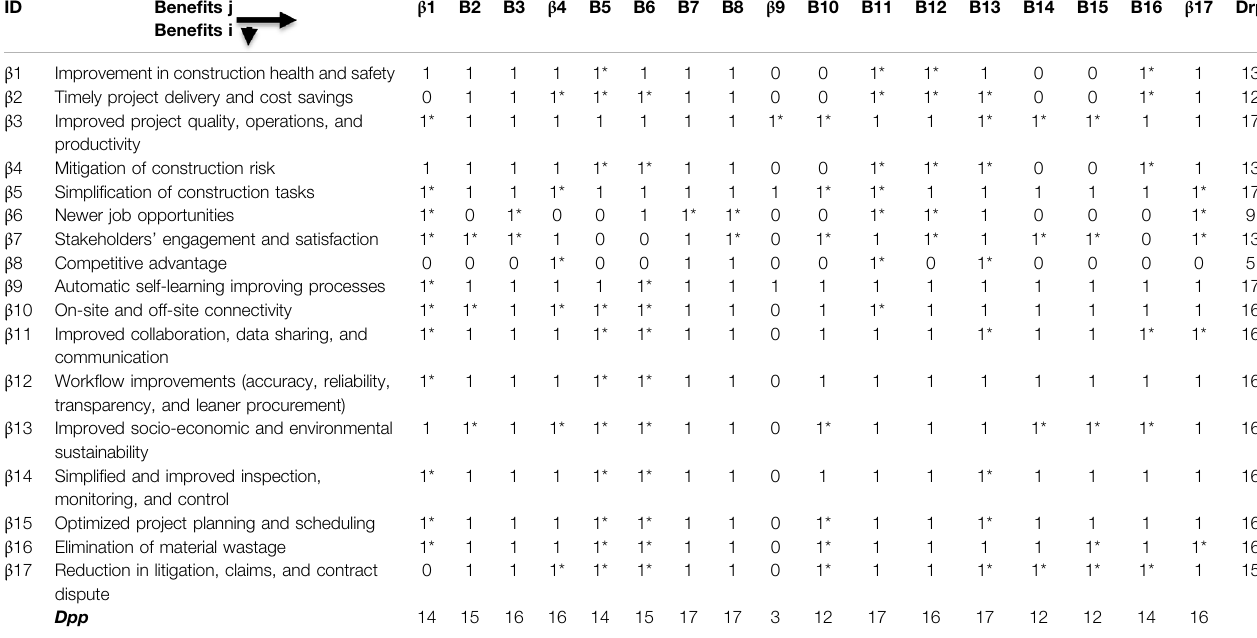
TABLE 6 | Final reachability matrix for bene fi ts of automation and arti fi cial intelligence.